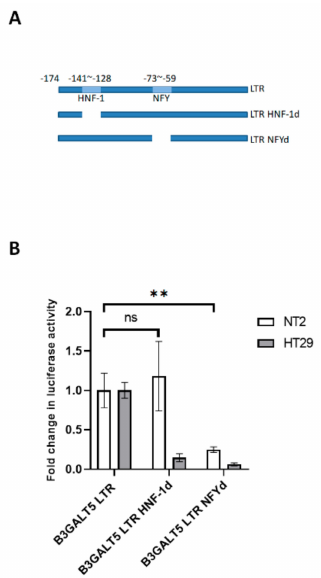
Figure 2. Transcription factors involved in B3GALT5-LTR expression. ( A ) The positions of the canonical HNF1- and NFY-binding sites on the B3GALT5 -LTR promoter are shown. ( B ) Expression of the Luc-LTR reporter construct with a deleted HNF-1 binding site in its promoter (HNF-1d) did not change in NT2 cells but was reduced in HT29 cells. Luciferase activity was greatly reduced when NT2 and HT29 cells were transfected with Luc-LTR with a deleted NFY binding site (NFYd). (**, p < 0.01 and ns: